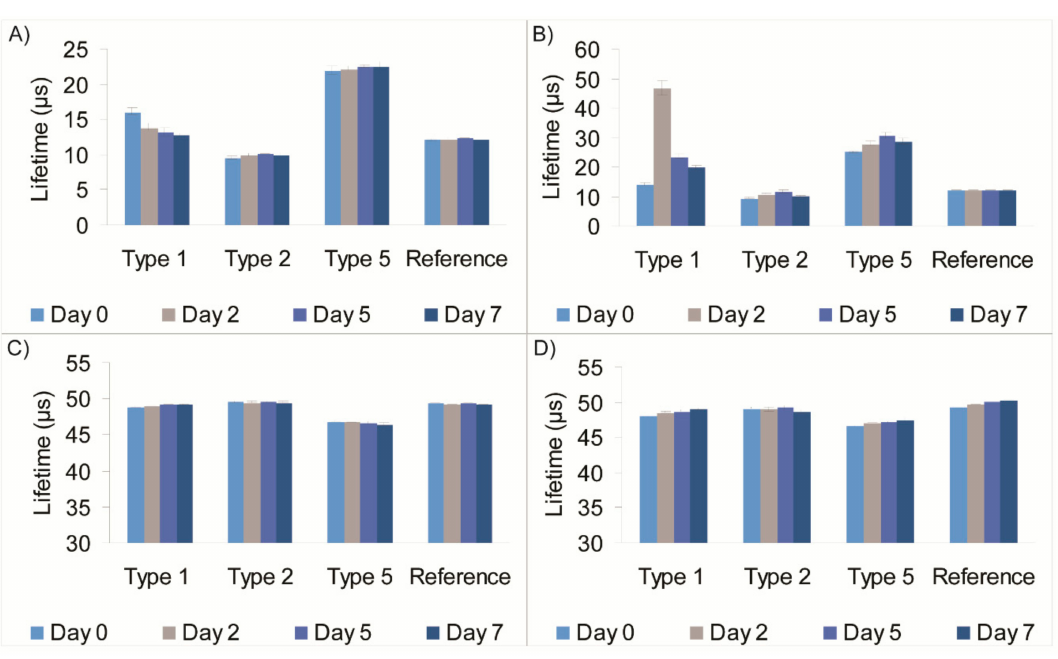
Figure 2. Lifetime values of sensors in: upright steak package ( A ); inverted steak package ( B ); upright chicken package ( C ); and inverted chicken package ( D